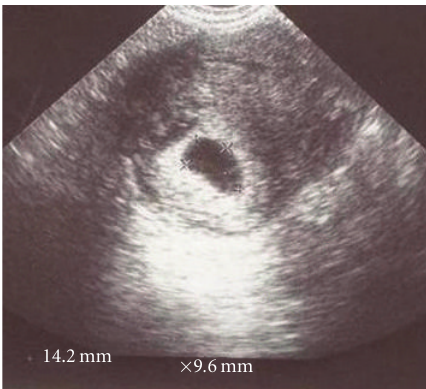
Figure 3: 6 × 6 mm cornual gestational sac after second local and third systemic MTX